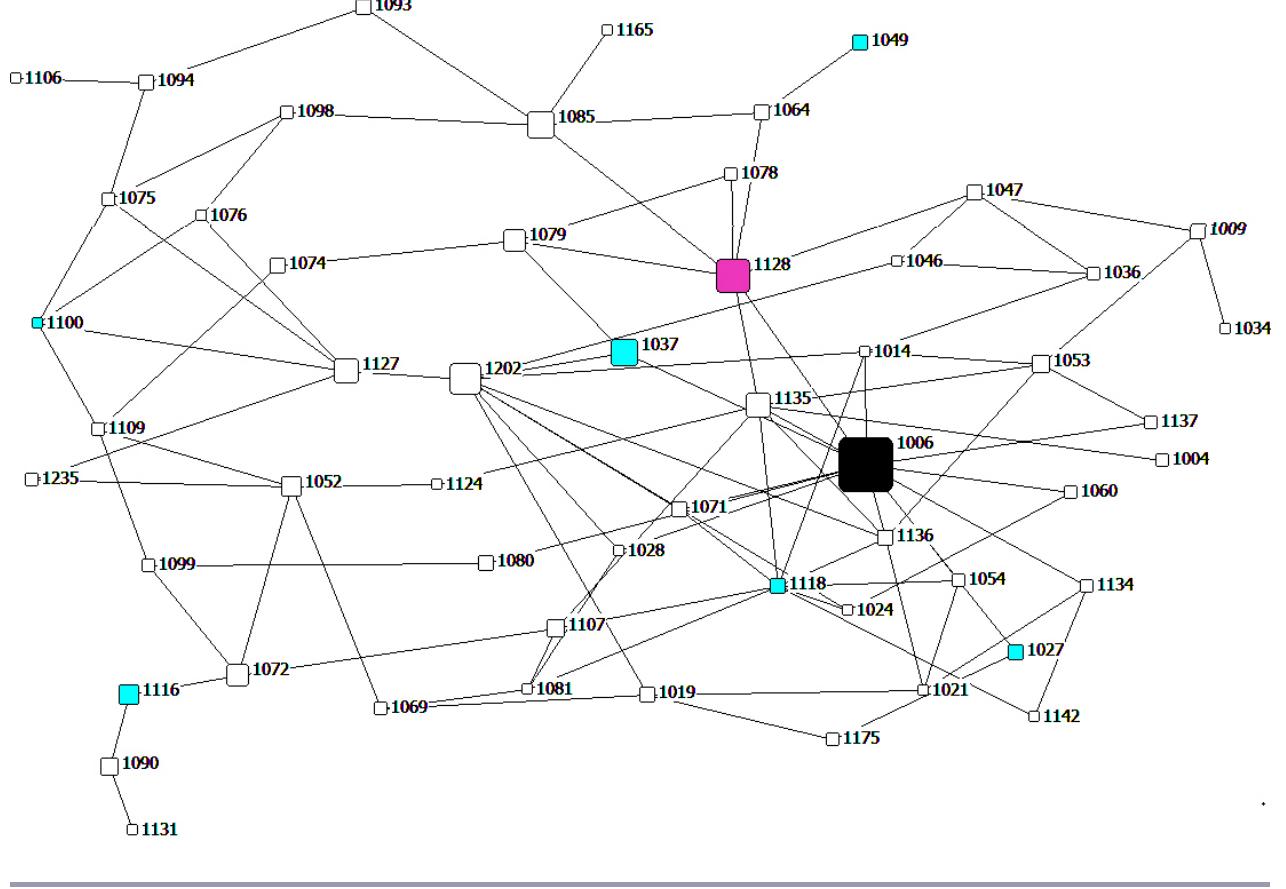
Fig. 7 . Information exchange network showing more centralized households (indicated by size of square) and community leaders (colored